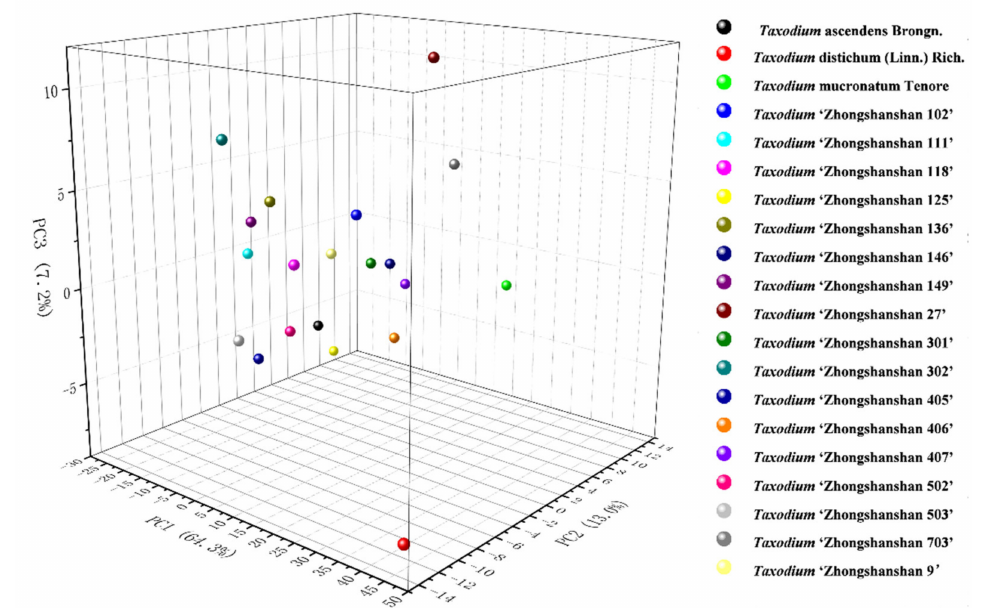
Figure 6. PCA analysis of T. ascendens , T. distichum , T. mucronatum , T. ‘Zhongshanshan 405’,